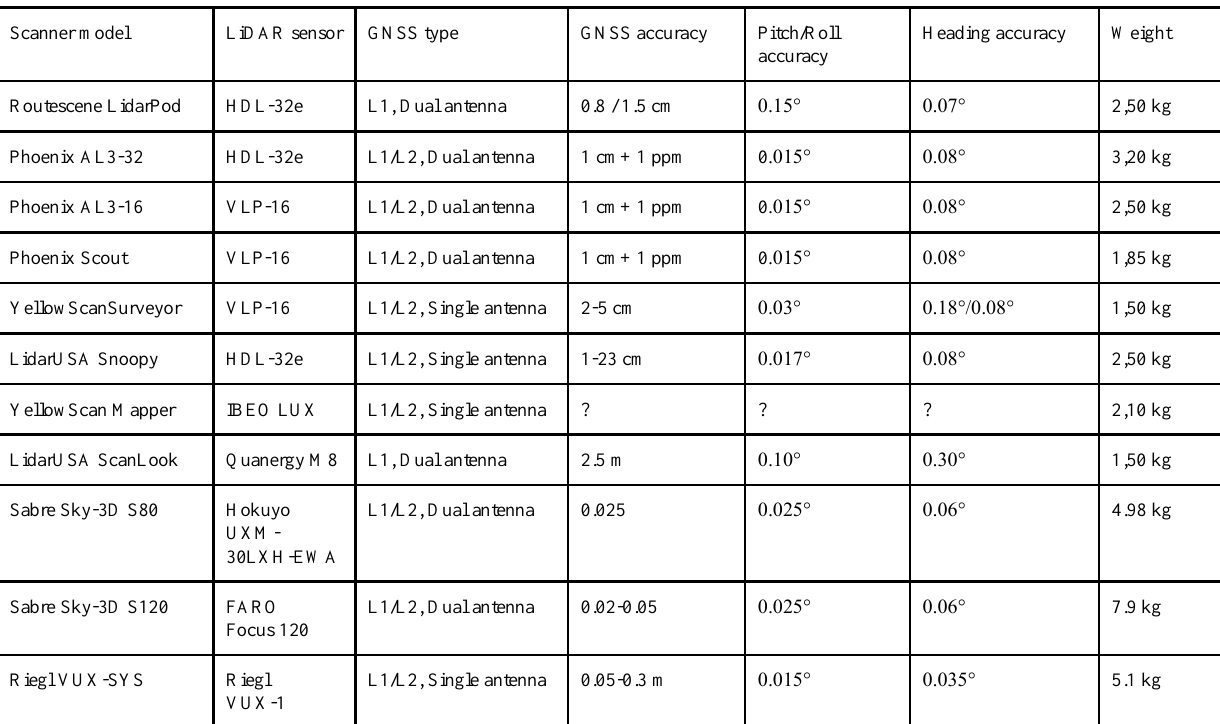
Table 2 UAV LiDAR systems